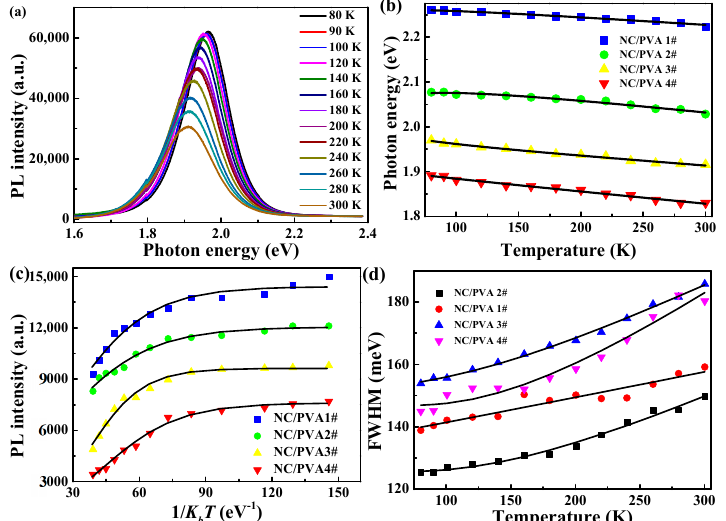
Figure 2. ( a ) The temperature-dependent PL spectra for CdTe NC/PVA 3# film. ( b ) Photon energy of the PL emission peak. ( c ) Integrating PL intensity and ( d ) FWHM for CdTe NC/PVA film; black solid lines are the best-fitted curves based on Equations (1)–(3). For traditional II-VI group semiconductor NCs, with increasing temperature, the PL peak position shifted to a larger photon energy band [30]. The temperature dependence on the bandgap can be expressed by the empirical Varshni equation [31,32] as